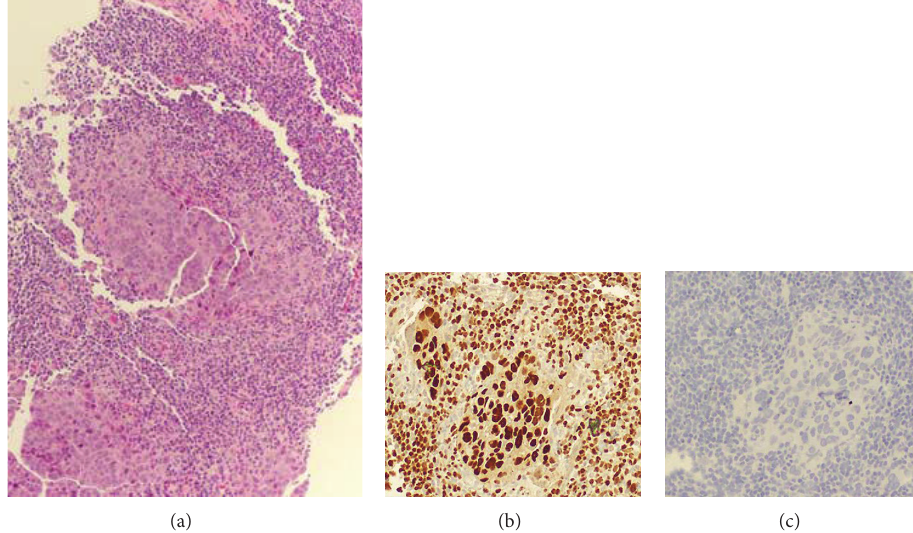
Figure 1: (a) H&E stained section from the biopsy core obtained from the axillary node. Poorly differentiated cells with a vague papillary configuration are seen. (b) Pax-8 staining performed on core biopsy shows nuclear staining. (c) Mammaglobin staining performed on core biopsy is negative.